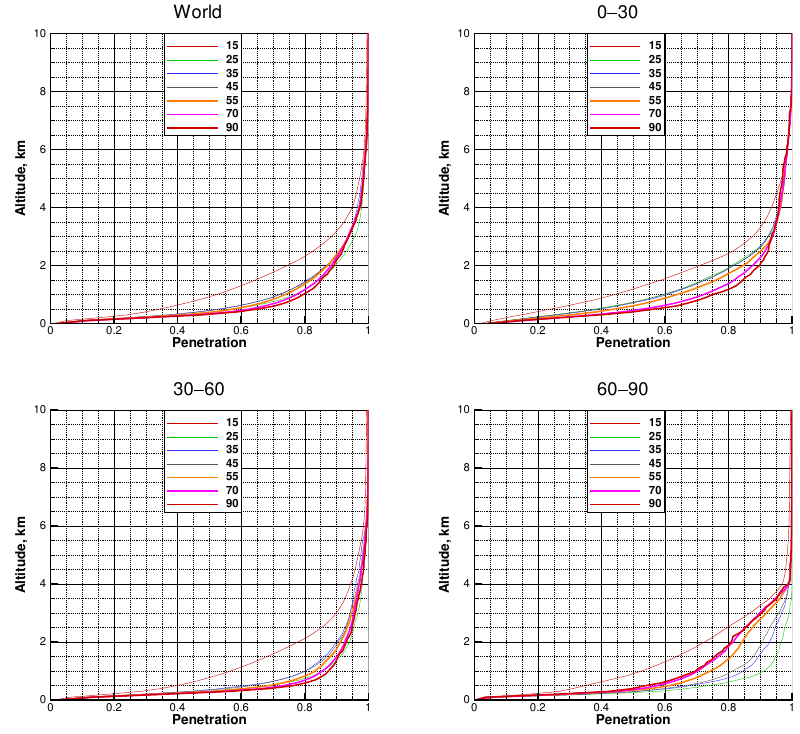
Figure 13. Similar to Figure 4. METOP-B, penetration, dynamic